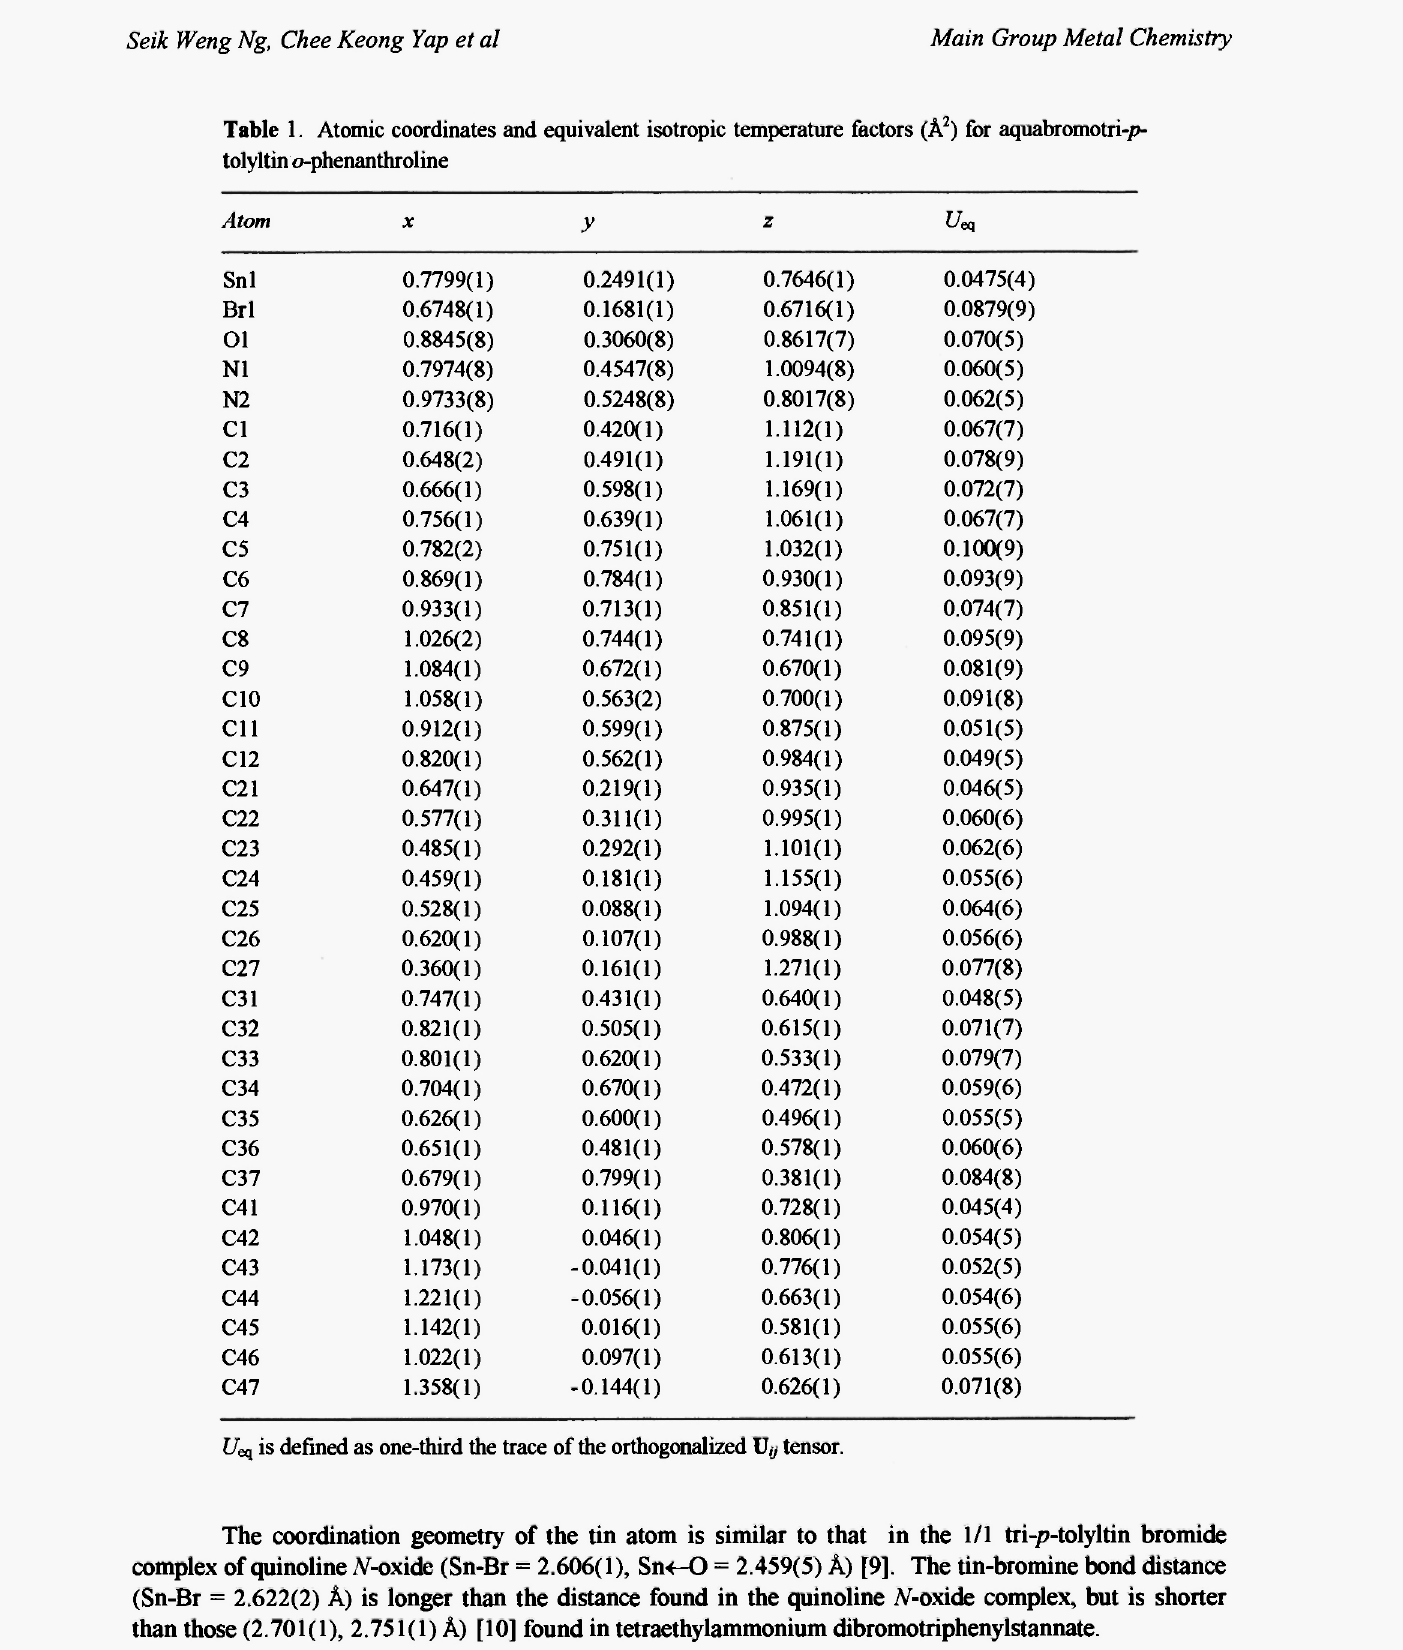
Table 1 . Atomic coordinates and equivalent isotropic temperature factors (A 2 ) for aquabromotri-p- tolyltin